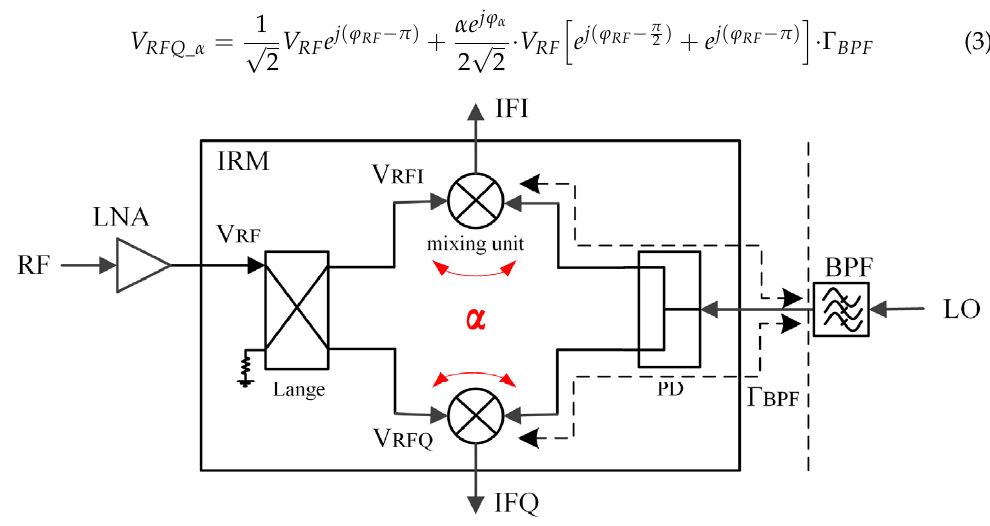
Figure 4. Analysis of the influence of RF-LO port mutual coupling α on the amplitude and phase imbalance.